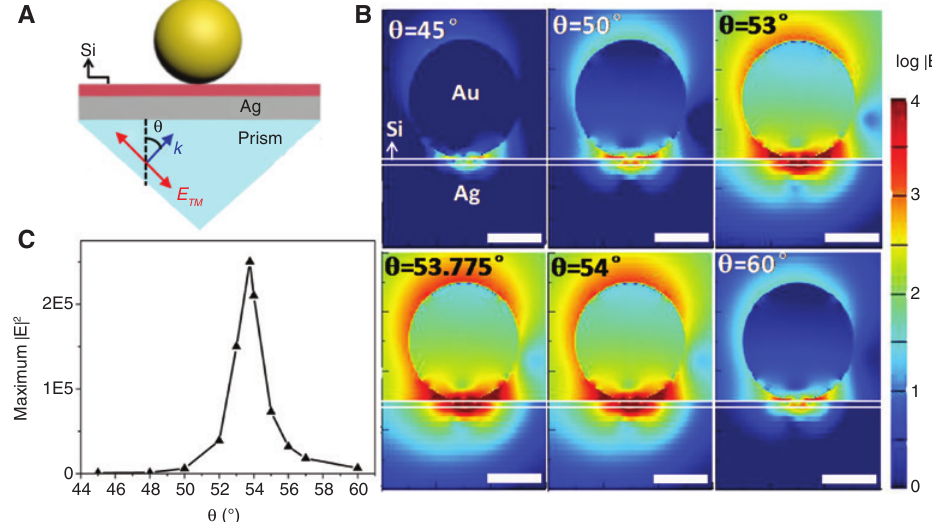
Figure 16: Simulated field enhancement in the ESP-LSP coupling in prism configuration versus incidence angle. (A) Schematic illustration of an Au nanosphere over an Ag film separated by a thin Si spacer. The silver film is coated on a SF-11 prism in the KR configuration. θ is the incidence angle in the prism at wavelength 655 nm. (B) Electric field distributions. (C) Maximum electric field enhancement. An Au sphere of 40 nm diameter is used on 46.4 nm Ag film with 2 nm Si spacer with different incident angles θ . The Ag film is coated on a SF-11 prism. The surrounding medium is water. The scale bar in each figure of (B) is 20 nm. In this study, all the calculations are performed using the FDTD simulation program (FDTD solutions 8.6, Lumerical solutions, Inc., Vancouver, Canada). Reproduced with permission from